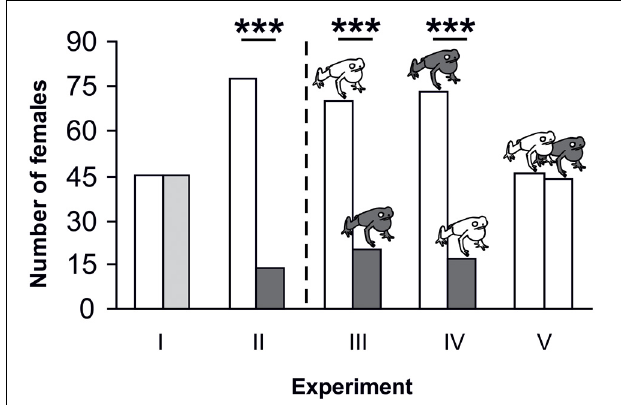
FIGURE 4 | Global results of playback experiments for all tested populations. The bars present the number of females which selected one or the other signal or signal combination. Bar coloration indicates call type, model frog coloration indicates model type presented in the experiments (white, local call/local model; light gray, local group-call; dark gray, non-local group-call/ non-local model). Asterisks indicate significant preferences for one choice over the other ( ∗∗∗ P < 0 . 001; Table 1 ).